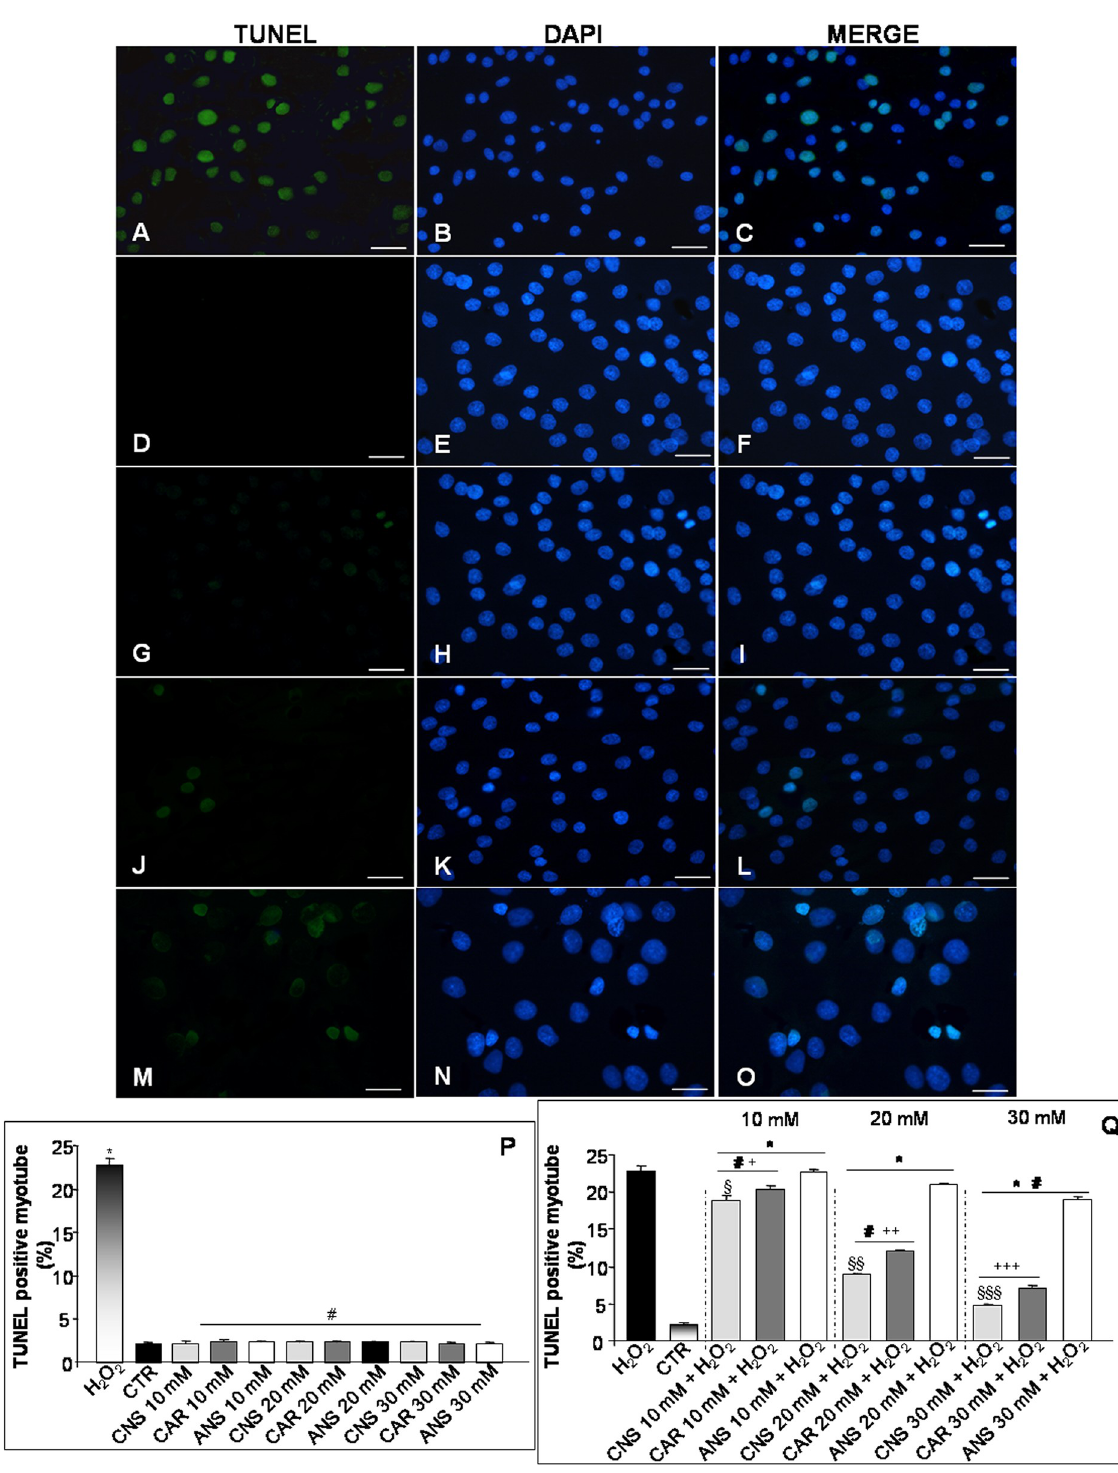
Fig 2. Myotube apoptotic evaluation. Photomicrographs of TUNEL assay (greenstaining) showing myotubes treated with hydrogen peroxide— H 2 O 2 (A-C), untreated control myotubes—CTR (D-F), myotubes pre-incubated with carnosinol (30 mM) followed by hydrogen peroxide treatment—CNS + H 2 O 2 (G-I), pre-incubated with carnosine(30 mM) followed by hydrogen peroxide treatment—CAR + H 2 O 2 (J-L) and pre- incubated with anserine (30 mM) followed by hydrogen peroxide treatment—ANS + H 2 O 2 (M-O). DAPI (blue staining) is used to locate the nuclei of the cells. Bar equal: 20 μ m.The graphs (P and Q) summarize the quantitative analysis of TUNEL positive myotubes of all the experimental cell groups. � p � 0.05 vs CTR; # p � 0.05 vs H 2 O 2; § p � 0.05 vs CAR + H 2 O 2 10 mM; §§ p � 0.05 vs CAR + H 2 O 2 20 mM; §§§ p � 0.05 vs CAR + H 2 O 2 30 mM; + p � 0.05 vs ANS + H 2 O 2 10 mM; ++ p � 0.05 vs ANS + H 2 O 2 20 mM and +++ p � 0.05 vs ANS + H 2 O 2 30 mM.